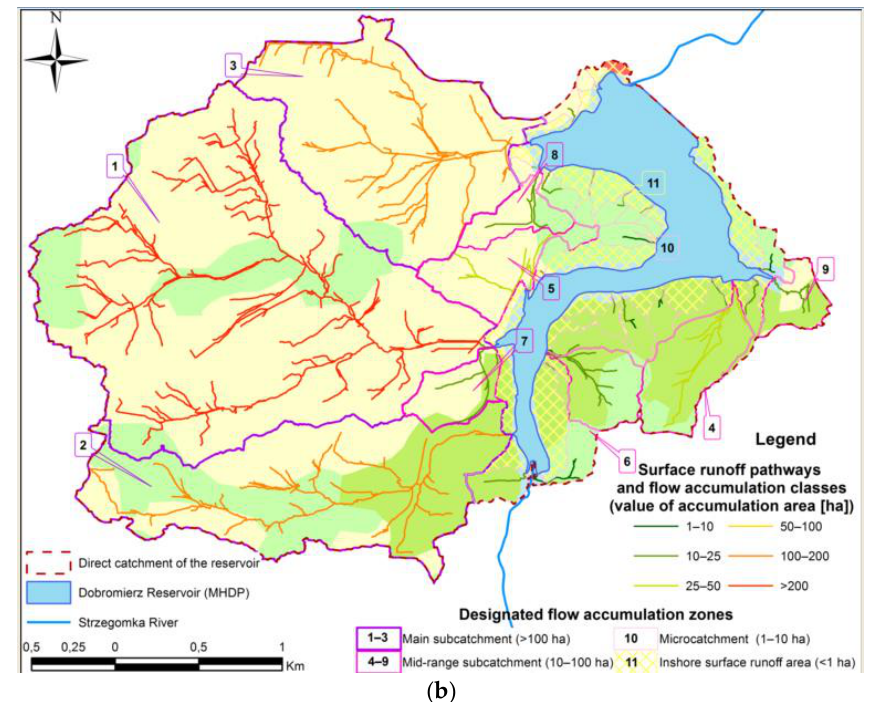
Figure 5. ( a ) Designed flow accumulation areas in the direct catchment of the Dobromierz Reservoir; ( b ) designed flow accumulation areas on the background of land use pattern (legend as in Figure 3).